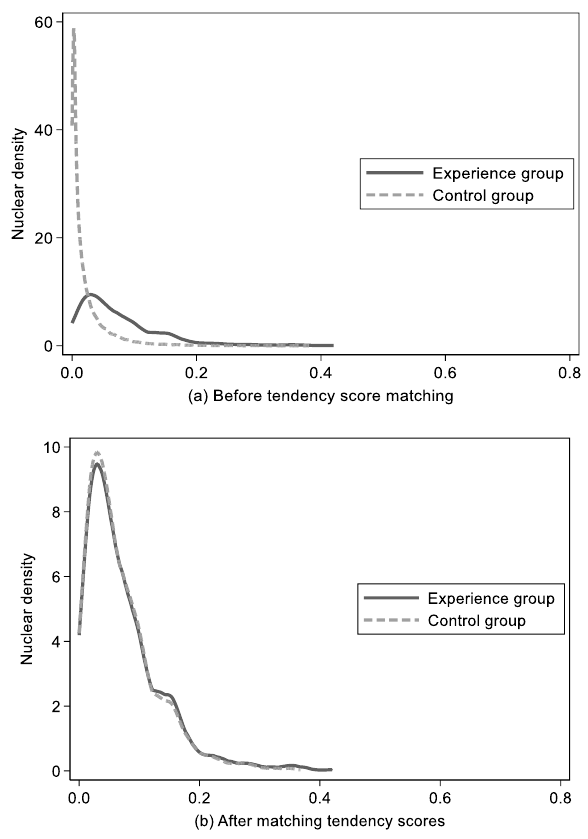
Figure 6. Kernel density function before and after propensity score matching.